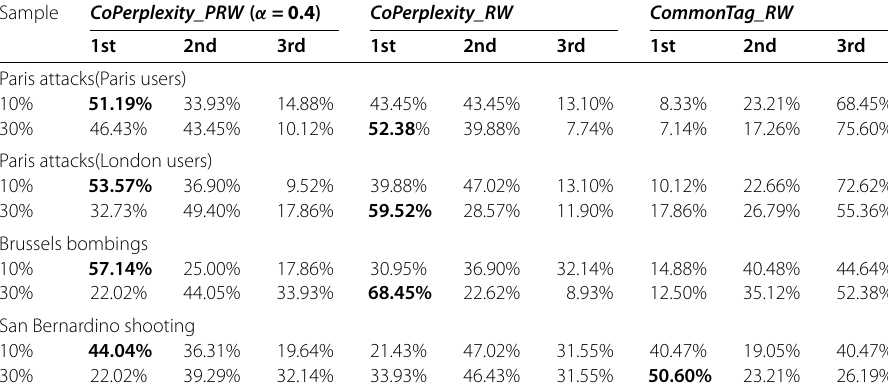
Table 2 Performance of the top three sampling methods in capturing the most attentive hashtags during the event week (168 hours), evaluated based on Precision@100 each hour over different sampling conditions (10% and 30% of the complete user set) Sample CoPerplexity_PRW ( α = 0.4 ) CoPerplexity_RW CommonTag_RW 1st 2nd 3rd 1st 2nd 3rd 3rd Paris attacks(Paris users) 10%